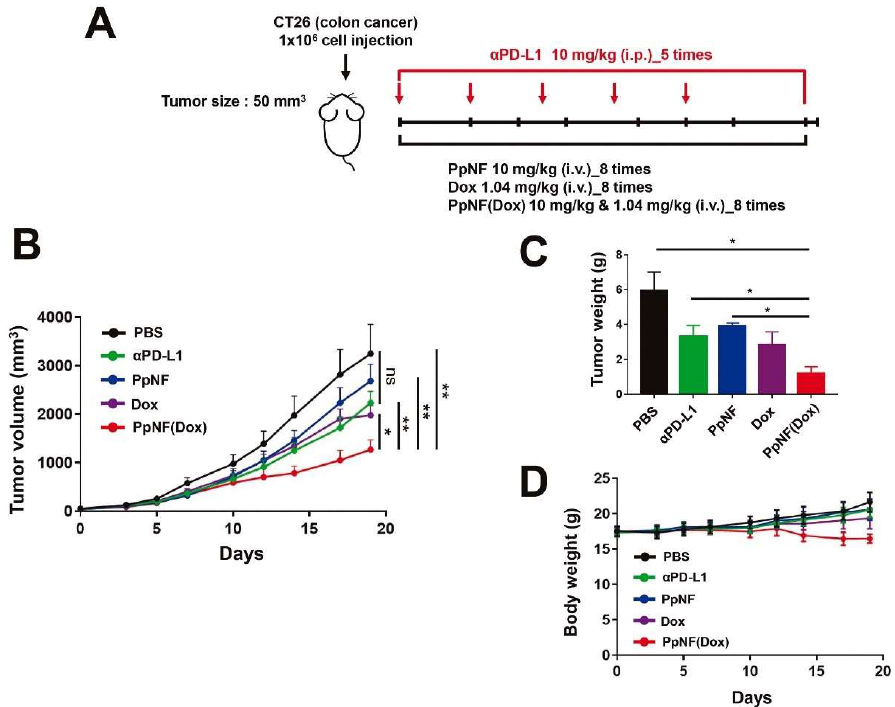
Figure 5. Antitumor activity of FNs displaying the PD-L1 binding peptide (PpNF). ( A ) Experimental schemes for antitumor treatments. Mice bearing s.c. CT26 syngeneic colon tumors were treated with DOX-loaded PpNF (PpNF(Dox)) or PpNF or Dox administered by i.v. injection three times per week. Anti-PD-L1 antibody was administered by i.p. injection twice per week. ( B ) Tumor volumes after treatment. ( C ) The weights of excised tumors from each group at the 19-day post-injection. ( D ) Body weights. The data represent means ± SEM (* p < 0.05 and ** p < 0.01; t -test). Reproduced with permission from [35], Elsevier,